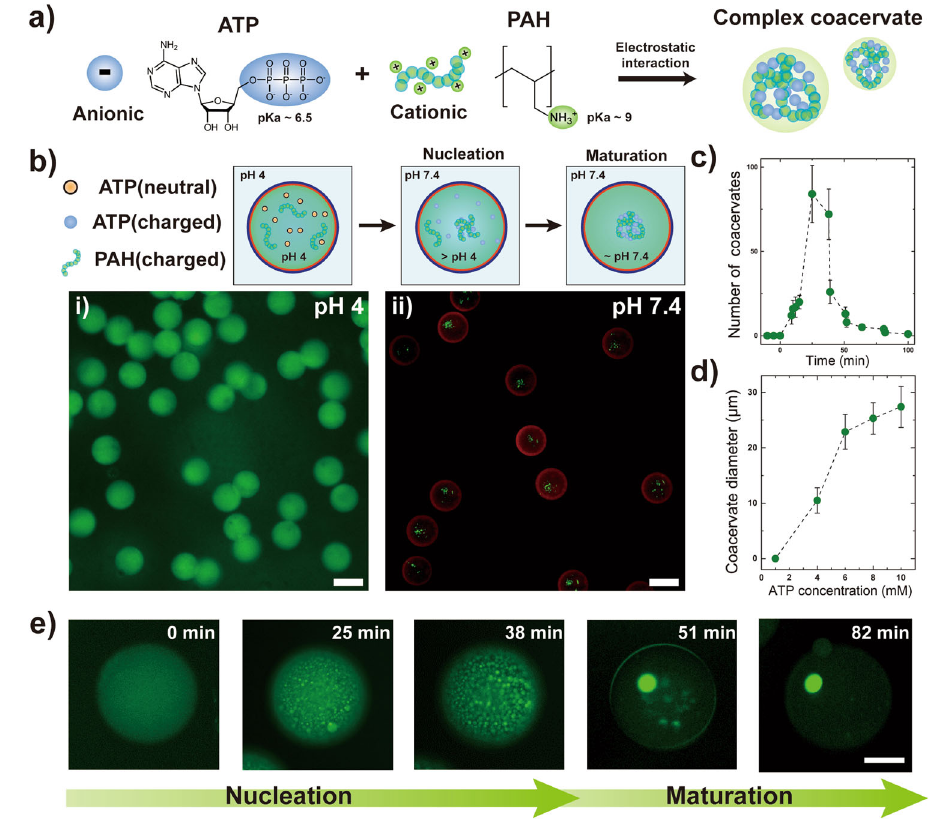
Fig. 2 | pH-induced complex coacervation in polymersomes. a Schematics illustrating the complex coacervate formation between adenosine triphosphate (ATP) and poly(allylamine hydrochloride) (PAH). b Schematics illustrating the pH- induced complex coacervates in polymersomes. (i) Fluorescence micrograph showingnonoticeableformationofcomplexcoacervateswithinthepolymersomes at pH 4. (ii) Fluorescence micrograph showing complex coacervate formation within the polymersomes 45min after adjusting the pH to 7.4. Both scale bars represent100 µ m. c Plotshowingthechangeinthe numberof coacervate droplets